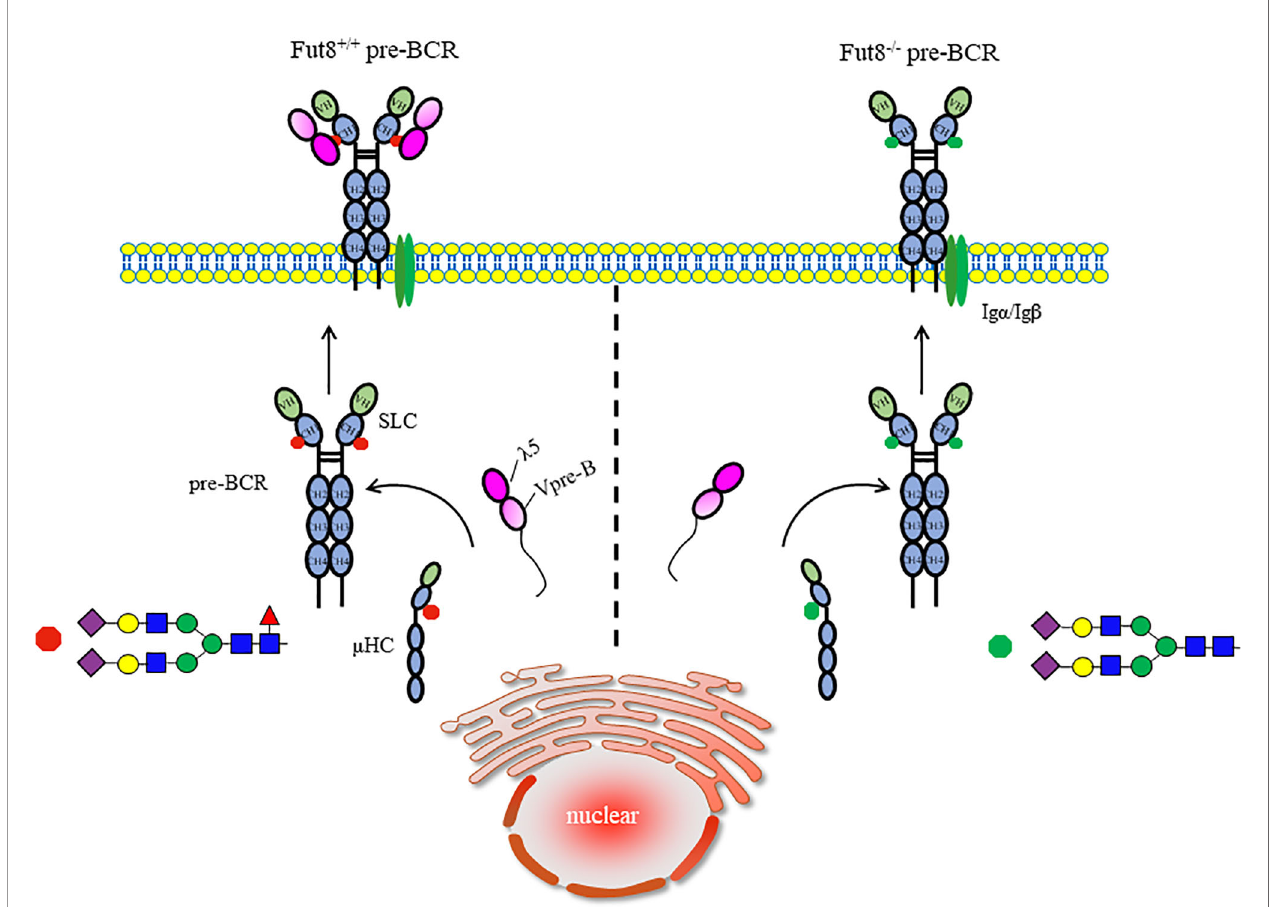
FIGURE 3 | Core fucosylation regulates the assembly of pre-BCR. The early B cells growth depends on the assembly of pre-BCR. The conserved N 46 -glycosylation site on C H1 domain of m HC played a critical role in modulation of the interaction of m HC and l 5 before the formation of pre-BCR. Removal of core fucose of m HC impaired the interaction between m HC and l 5, and pre-BCR assembly, which is necessary and suf fi cient for signal transduction via pre-BCR and early B cell